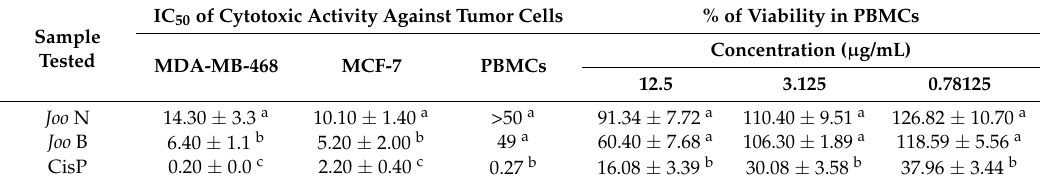
comparison range